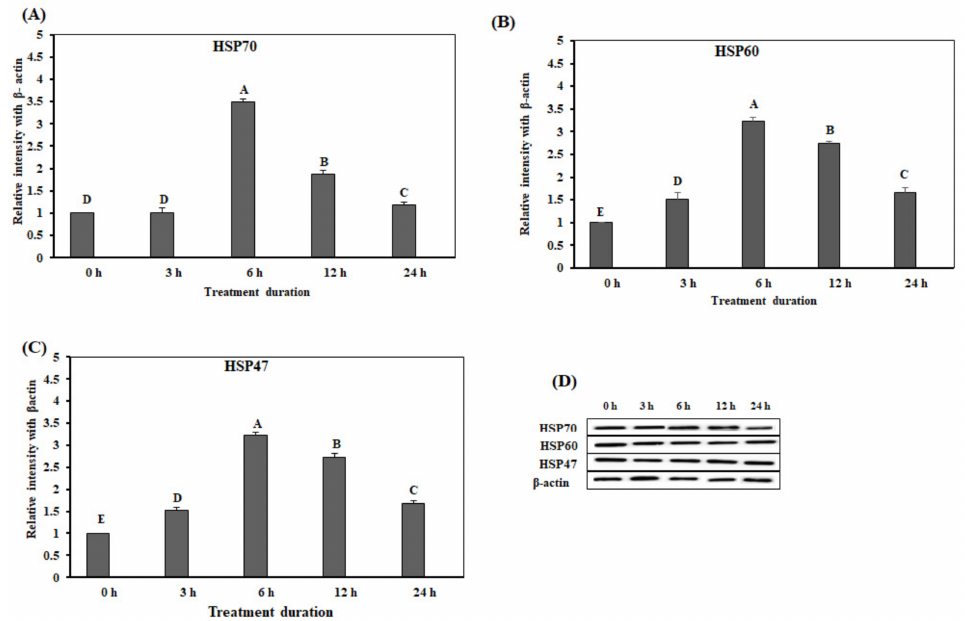
Figure 5. The protein expression of the heat shock proteins in the jejunum of chickens exposed to acute heat stress for di ff erent durations of time ( n = 8). The mean relative expression of HSP70 ( A ), HSP60 ( B ), and HSP47 ( C ). ( D ) Western blot analysis results. A–E HSP70 , HSP60 , and HSP47 in the columns with the di ff erent superscript letters di ff er significantly ( p < 0.05) among the di ff erent heat exposure durations.